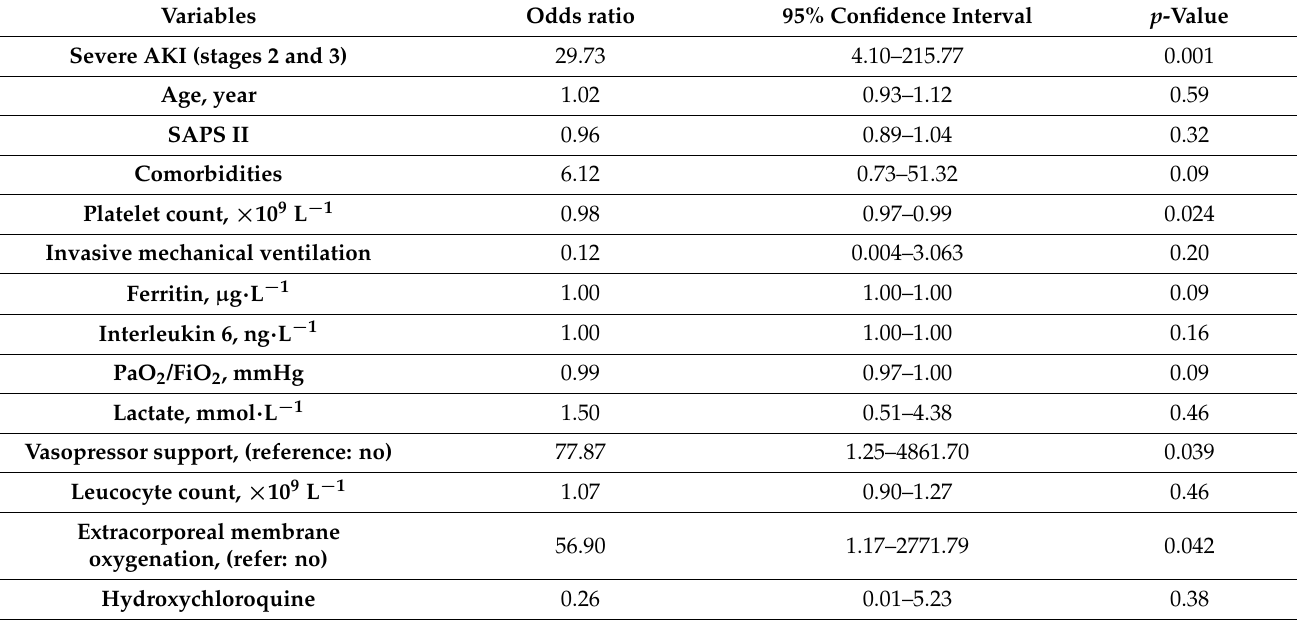
Table 4. Factors associated with hospital mortality (multivariable logistic regression